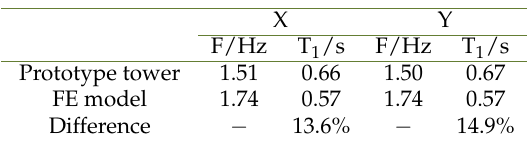
Table 9. Comparison of the natural periods between the model and the prototype